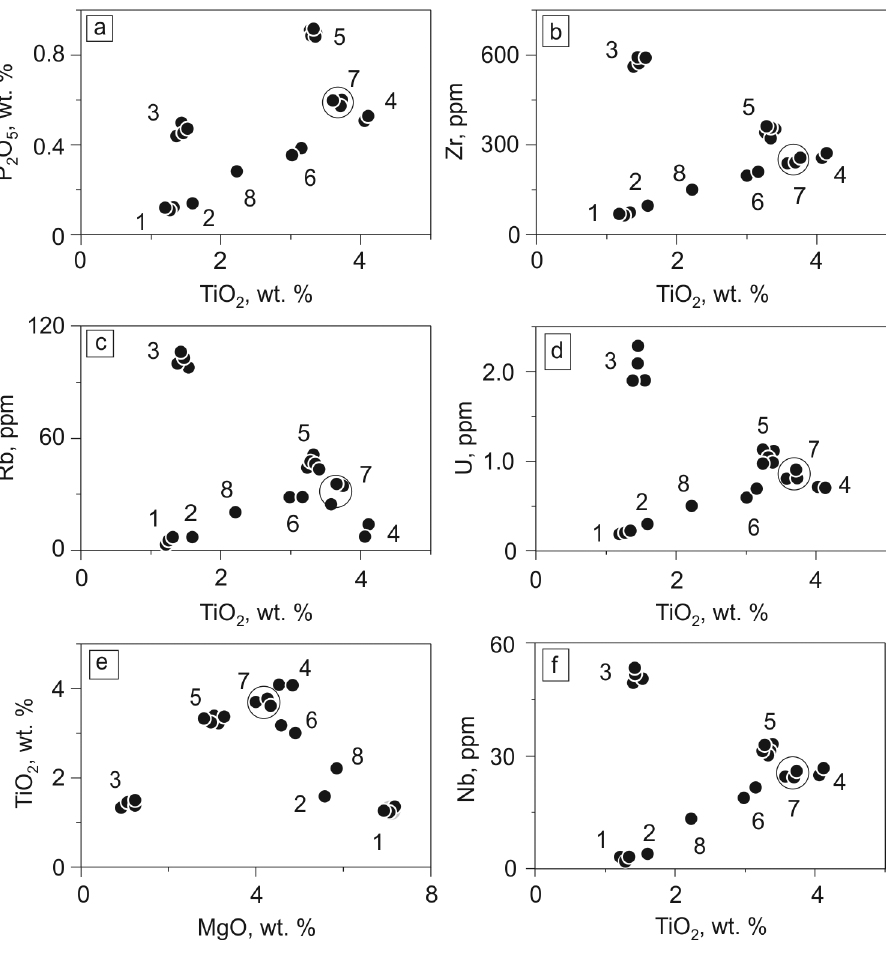
Figure 5 - (a)-(f) Chemical variation diagrams displaying the characteristic composition (TiO each lava flow in the district.